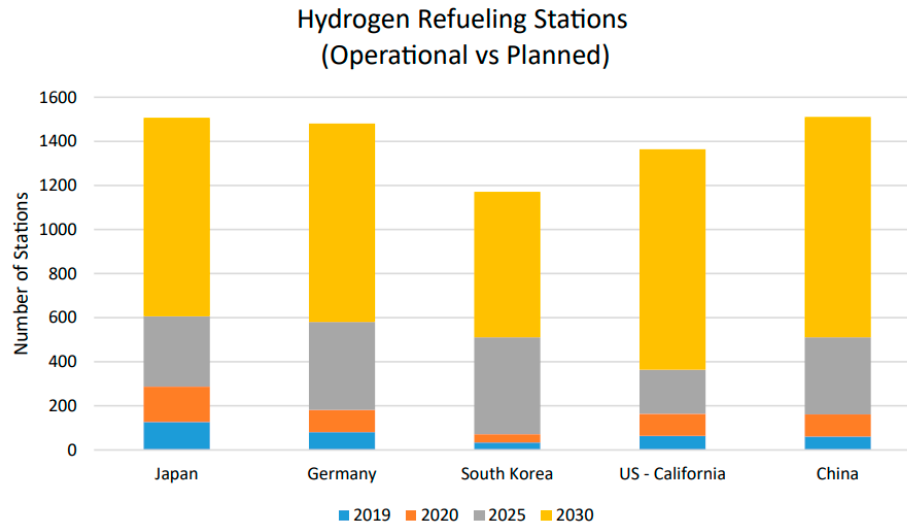
Figure 8. Current and planned number of hydrogen stations worldwide [18].